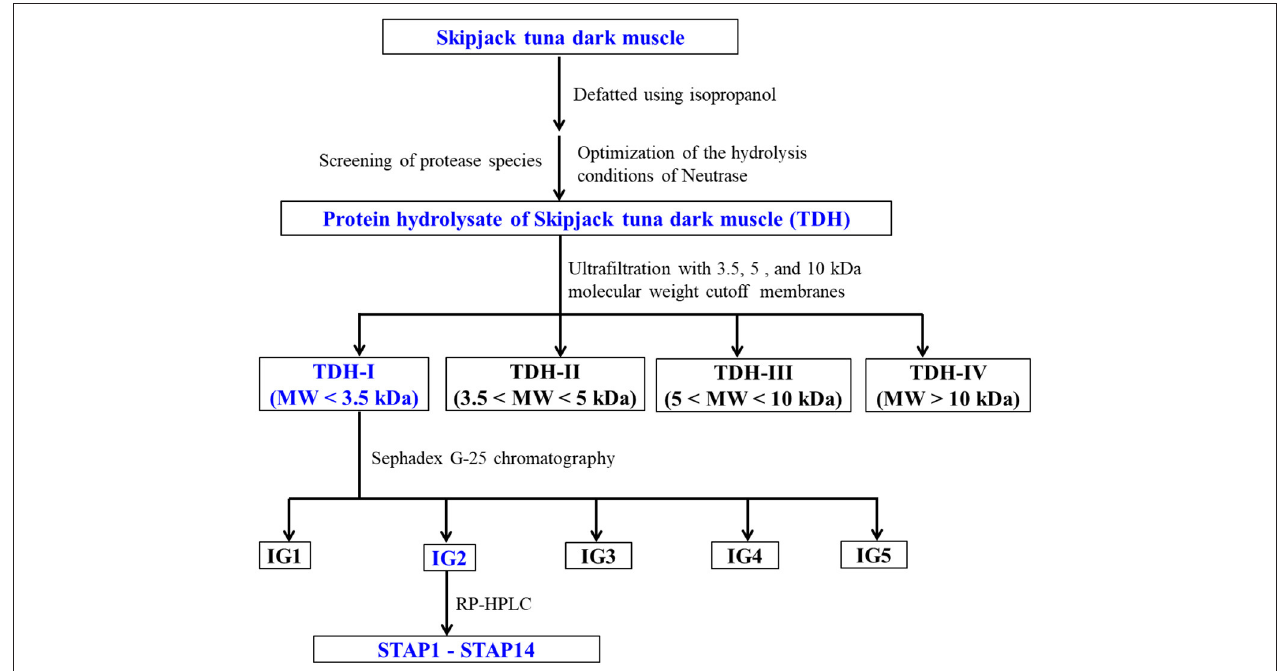
FIGURE 1 | Flow diagram of purifying ACEi peptides from protein hydrolysate (TDH) of skipjack tuna ( Katsuwonus pelamis ) dark muscle prepared using